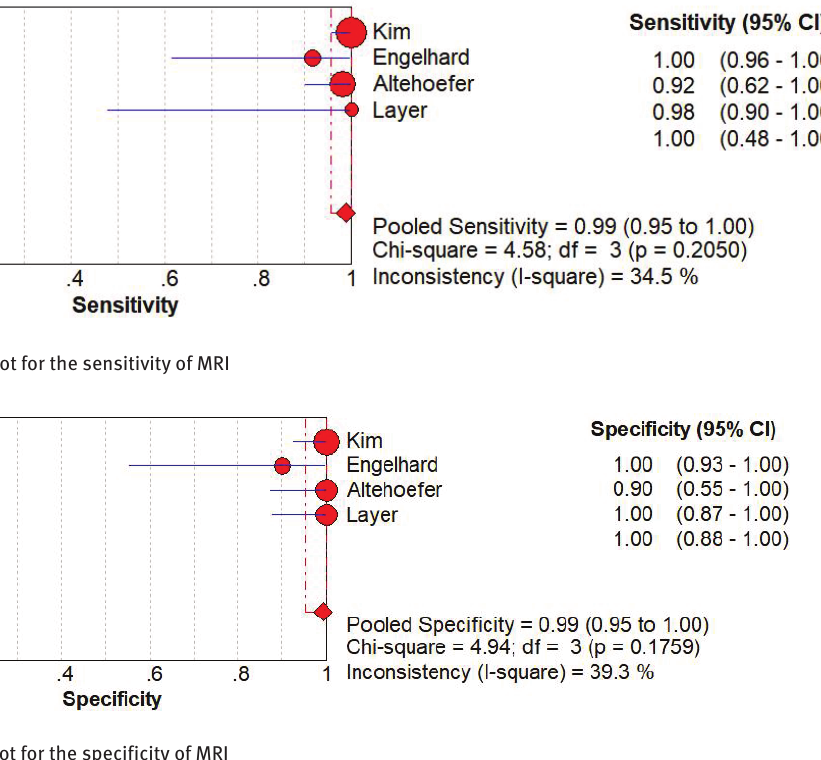
Figure 3: The plot for the specificity of MRI